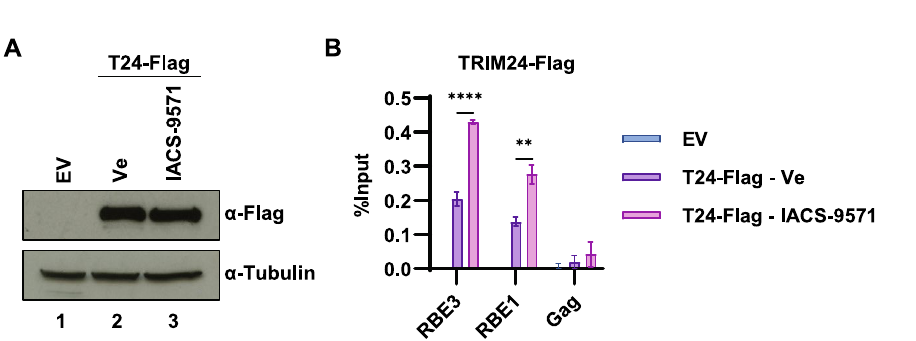
Figure 7. Association of TRIM24 with the HIV-1 LTR is enhanced upon IACS-9571 treatment. ( A ) Jurkat mHIV-Luciferase cells were transduced with lentivirus expressing Flag tagged TRIM24 (T24-Flag, Lanes 2, 3) or an empty vector (EV, Lane 1). TRIM24-Flag transduced cells were treated with 10 µM IACS-9571 (Lane 3) or left untreated (Ve, Lane 2). Whole cell lysates were immunoblotted using the indicated antibody. ( B ) TRIM24-Flag transduced cells were left untreated or incubated with 10 µM IACS-9571. Following 4 h, ChIP was performed using the indicated antibody. Results are the average of qPCR performed in triplicate with standard deviation